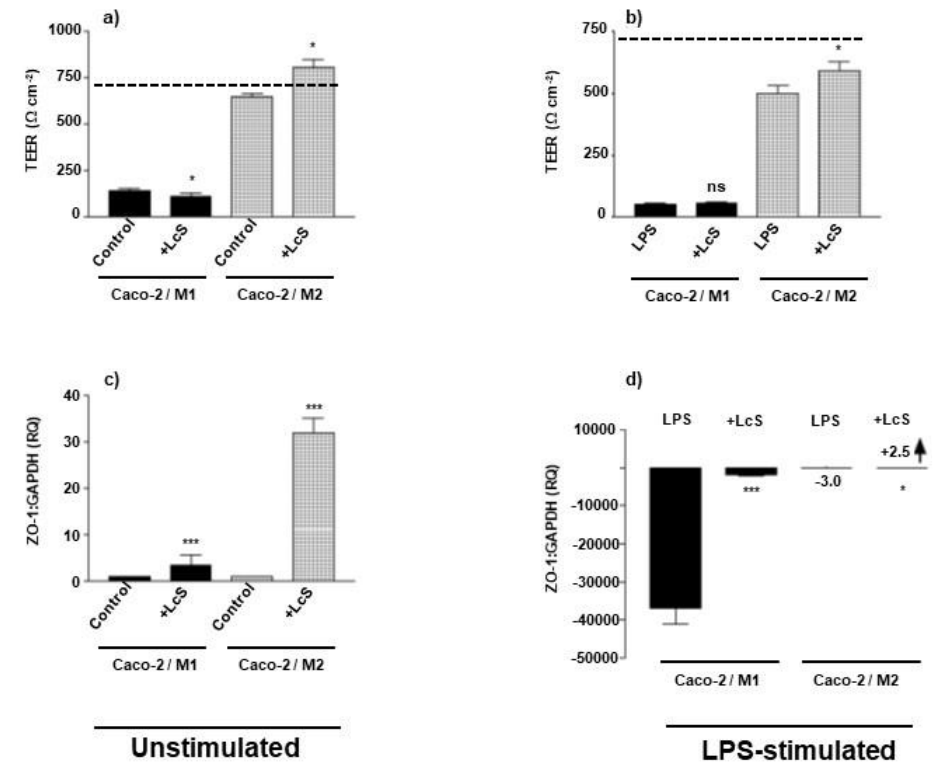
Figure 2. LcS fails to rescue barrier integrity in M1 Macrophage subset-epithelial cell co-culture. Caco-2 epithelial cells were cultured to confluence (intact barrier) in transwell inserts and incubated in co-culture with M1 (bold shading) and M2 (hatched shading) M ϕ subsets in the presence ( b , d ) or absence ( a , c ) of apically applied LPS stimulation (100 ng/mL). Barrier integrity of co-cultures was analysed by measuring TEER ( a , b ) (with un-stimulated Caco-2 control barrier integrity TEER being indicated by dashed line) and presented in Ω cm 2 , and mRNA expression of the tight junction molecule, ZO-1 ( c , d ) is presented as relative expression (RQ, Arbitary Units) compared to GAPDH housekeeping gene expression. Data displayed is a representative experiment with triplicate samples for n = 3 replicate experiments. Significant effects of LcS treatment on Caco-2/M ϕ co-cultures in the presence or absence of LPS stimulation are compared to non-LcS treated co-culture controls and significance indicated as * p < 0.05, *** p < 0.001 and ns, not significant and small-scale changes ( d ) are indicated by an arrow indicating augmentation/rescue and accompanied by the stated RQ relative expression